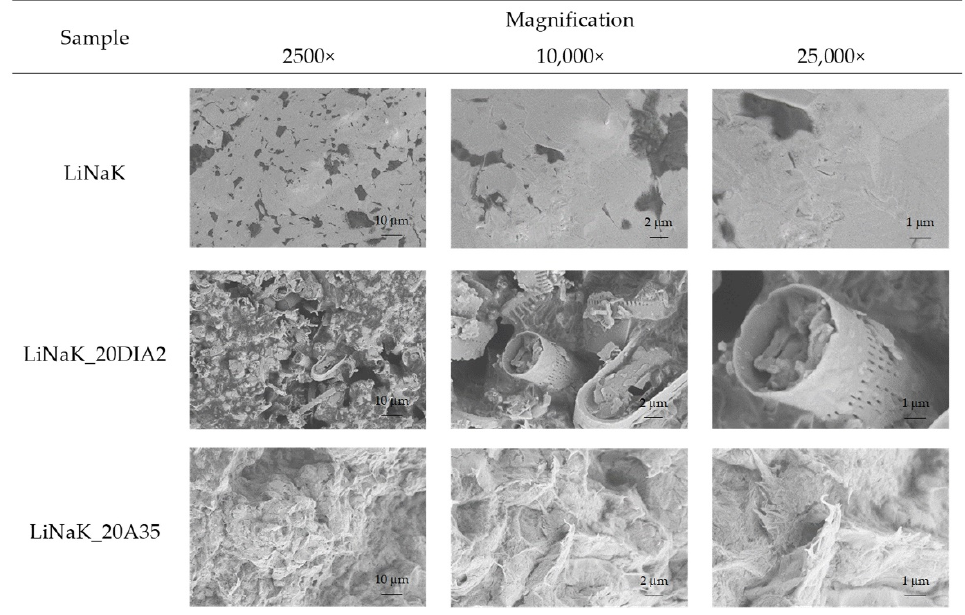
Figure 7. FESEM micrographs of LiNaK salts and its SSPCM produced with 20% wt. of DIA2 and A35.